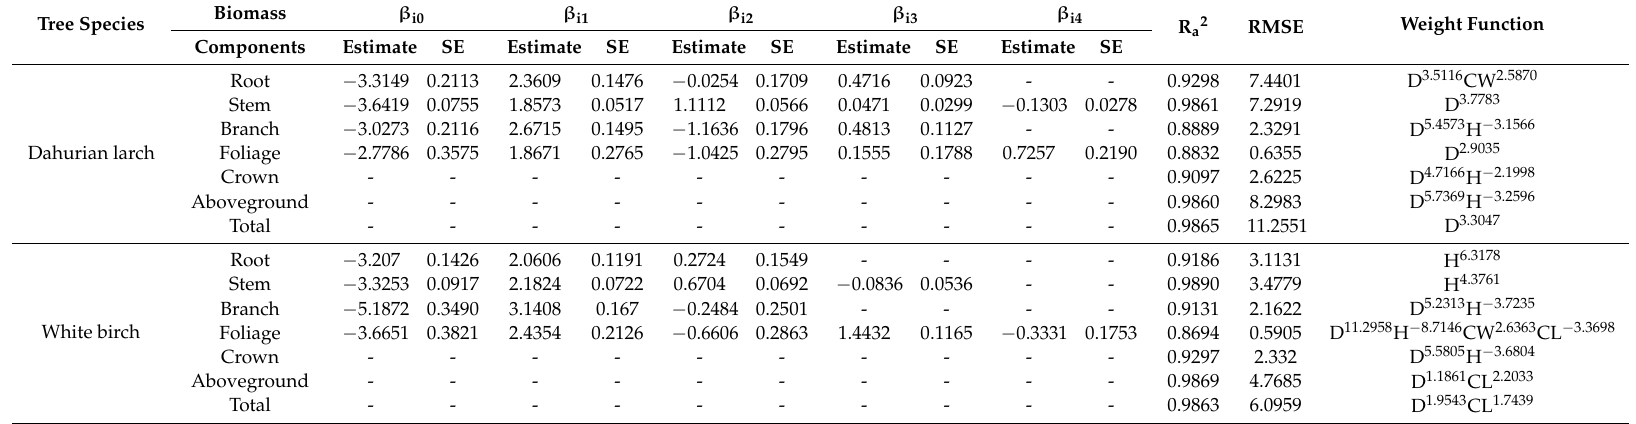
Table 4. Model coefficient estimates, standard errors, goodness-of-fit statistics, and weight functions for the additive system of biomass equations based on the best combinations of predictors (namely MS-1). MS = model system.